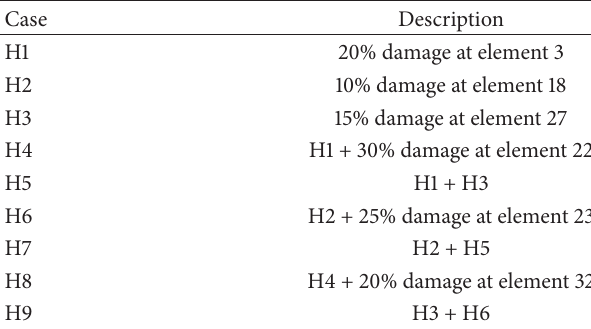
Table 10: Damage conditions to study the